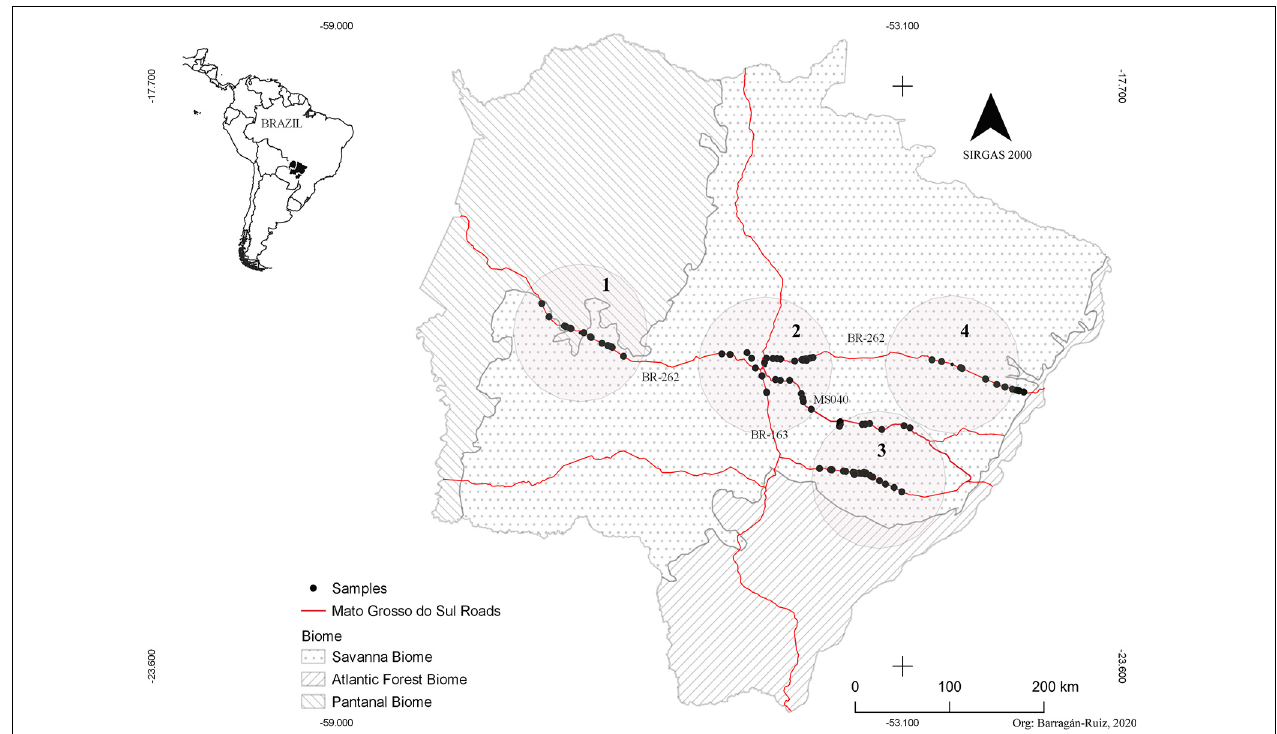
FIGURE 1 | Geographic location of Myrmecophaga tridactyla individual sampled. Red lines represent the main Mato Grosso do Sul roads, and black dots are each